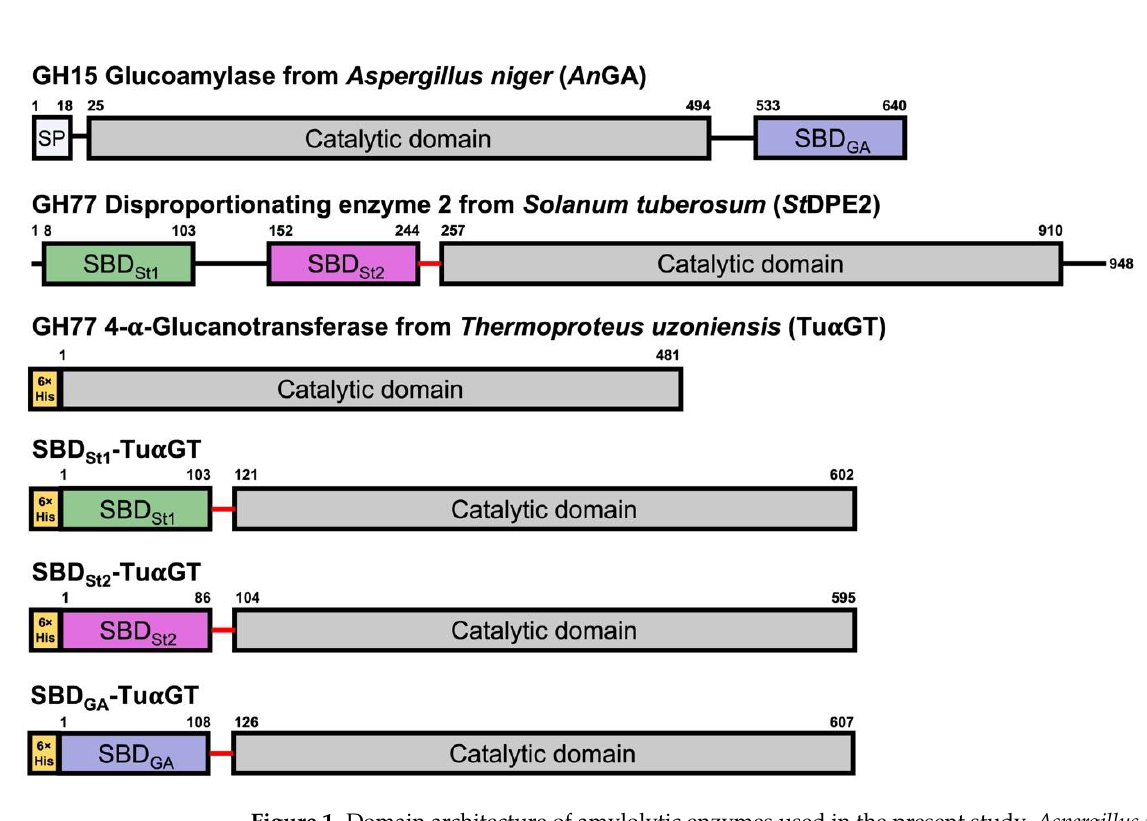
Table 1. The CBM20s originating from DPE2s, various other CAZymes, and related enzymes used in the present study a